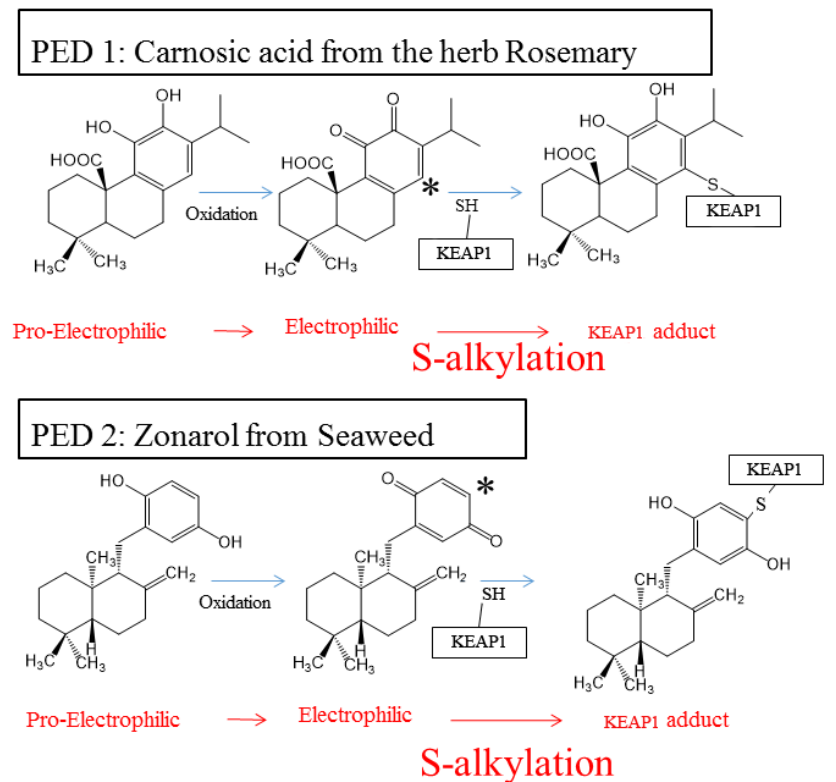
Figure 3. Activation of the KEAP1/NRF2 pathway by PEDs (PED 1, CA; PED 2, ZO). The PED compounds CA (with adjacent or “ ortho- ” position hydroxyl groups) 46,47,49,50 and ZO (with hydroxyl groups located directly across the ring, in the “ para -” position) 51,52 become oxidized to the electrophilic quinone form. CA and ZO quinones undergo nucleophilic attack by a critical KEAP1 cysteine thiol. The reaction forms a KEAP1-CA or KEAP1-ZO adduct. This results in release of NRF2 from KEAP1/NRF2 complexes, accumulation of NRF2 in the nucleus, and subsequent transcriptional activation of phase II enzymes 45,46 . Phase II anti-oxidant and anti-inflammatory enzymes reduce reactive oxygen species and thus improve the resilience of neurons. Importantly, the oxidation of hydroquinone (PED) to quinone (EP) is triggered by oxidative stress, which is then combatted by this transcriptional activity, as described in the text 45,49 . CA, carnosic acid; EP, electrophile; KEAP1, Kelch- like ECH-associated protein 1; NRF2, nuclear factor erythroid 2-related factor 2; PD, Parkinson’s disease; PED, pro-electrophilic drug; ZO,